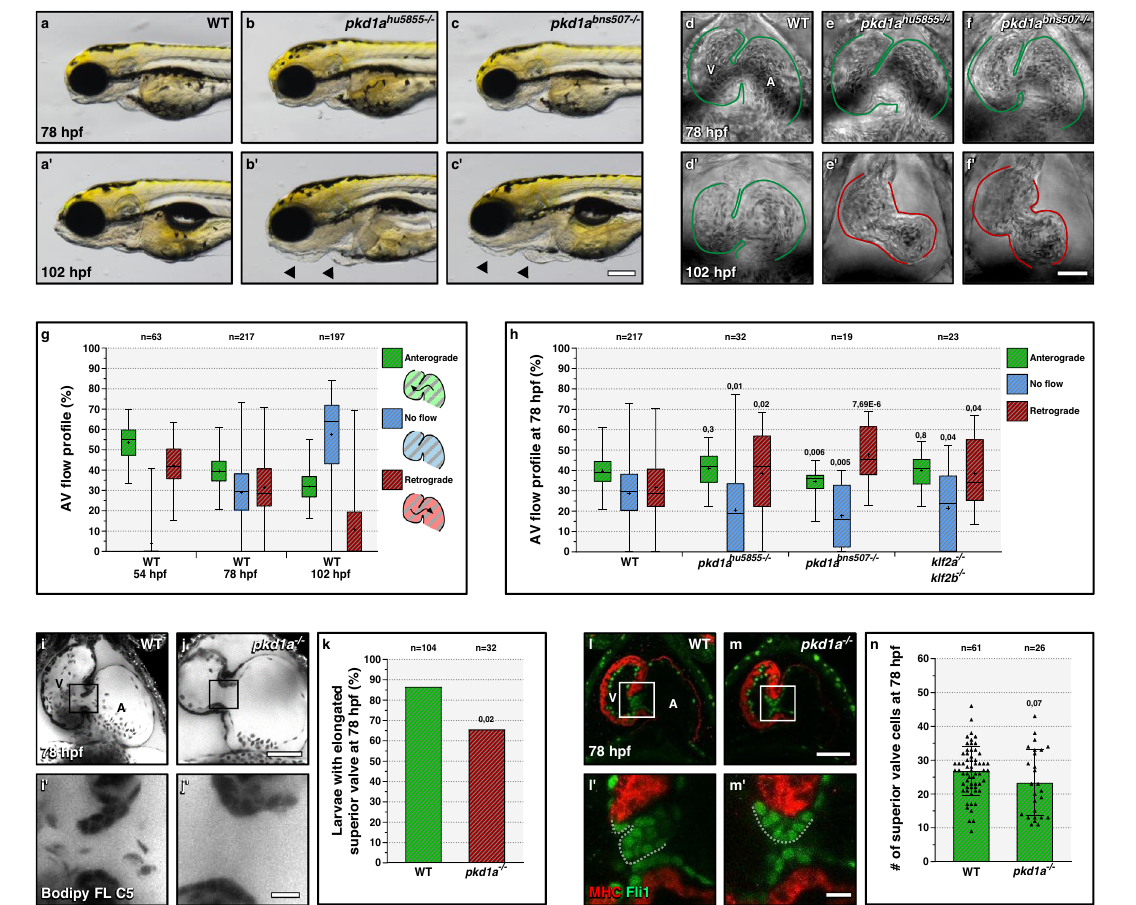
Fig. 1 | pkd1a isrequiredfor atrioventricularvalvedevelopment. a – c ′ Wild-type ( a - a ′ ) like morphology of pkd1a hu5855 ( b - b ′ ) and pkd1a bns507 ( c - c ′ ) mutants at 78 but not 102 hpf; arrows point to craniofacial defects and pericardial edema. d – f ′ Bright fi eld images of 78 and 102 hpf wild-type ( d - d ′ ), pkd1a hu5855 mutant ( e - e ′ ), and pkd1a bns507 mutant ( f - f ′ ) hearts; one time point of a spinning disc movie at atrial diastole; green and red lines outline the heart. g AV fl ow pro fi le of 54, 78, and 102 hpf wild-type zebra fi sh; average pro fi le of three cardiac cycles per zebra fi sh. h AV fl ow pro fi le of 78 hpf wild-type, pkd1a hu5855 mutant, pkd1a bns507 mutant, and klf2a; klf2b doublemutantlarvae;averagepro fi leofthreecardiaccyclesperzebra fi sh. i – j ′ Confocal imaging of 78 hpf wild-type ( i - i ′ ) and pkd1a mutant ( j - j ′ ) hearts stained with Bodipy FL C5-Ceramide; i ′ , j ′ are AV canal magni fi ed images of i , j . k Superior